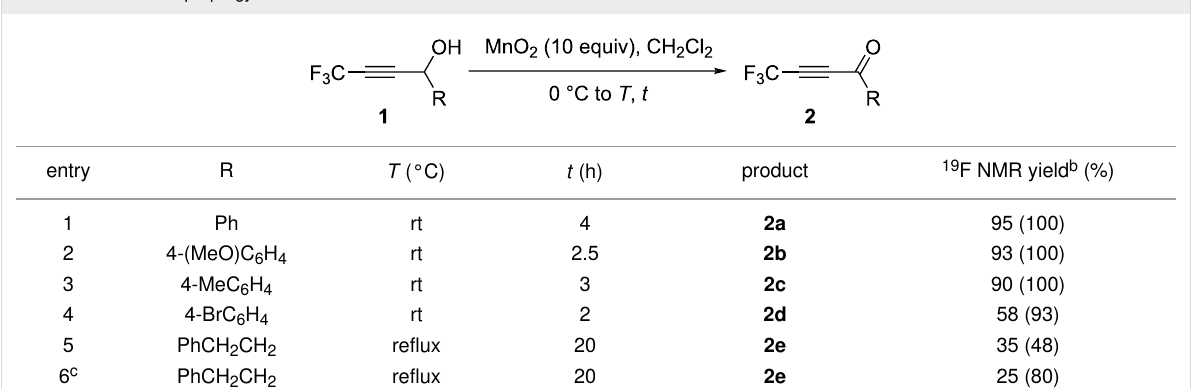
Table 1: Oxidation of propargylic alcohols 1 .